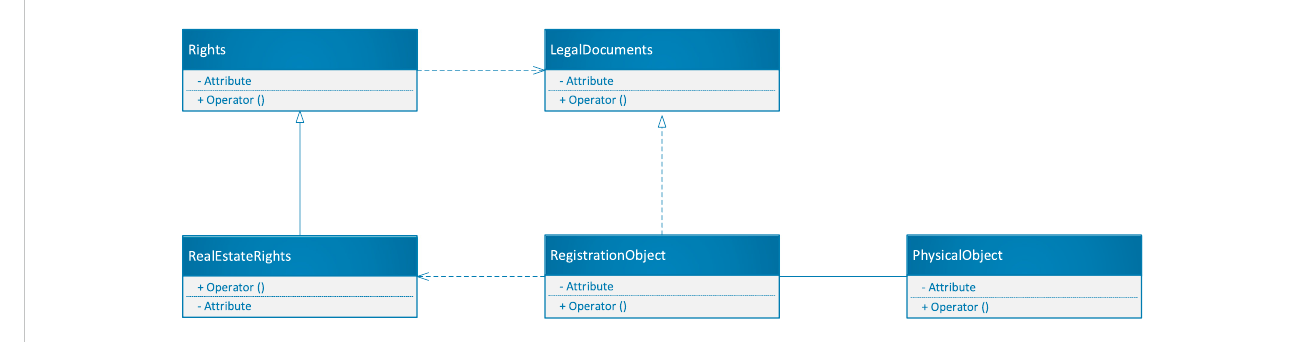
FIGURE 3 Abstract relation diagram of real estate registration class.